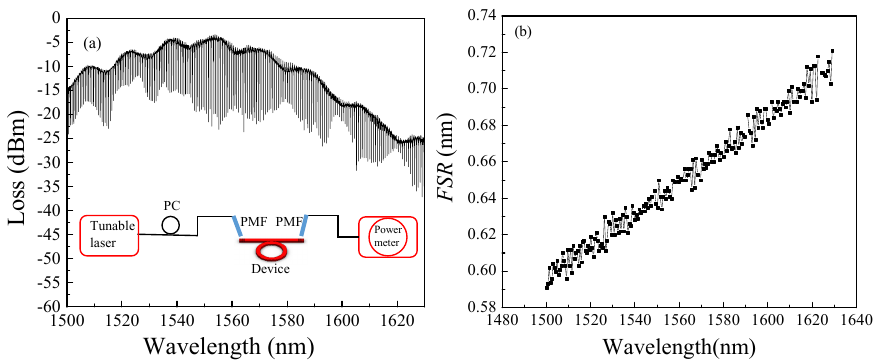
(SANTEC MPM200) with 1 pm wavelength resolution and shown in Figure 6a. The insert shows the experimental setup. According to the spectrum data, the free spectral range ( FSR ) is extracted and shown in Figure 6b. It can be seen that FSR increases gradually with the wavelength. Note that, the transmission loss of the waveguide is estimated to be 1.82 dB/cm by measuring the fiber-to fiber losses of waveguides with different lengths.